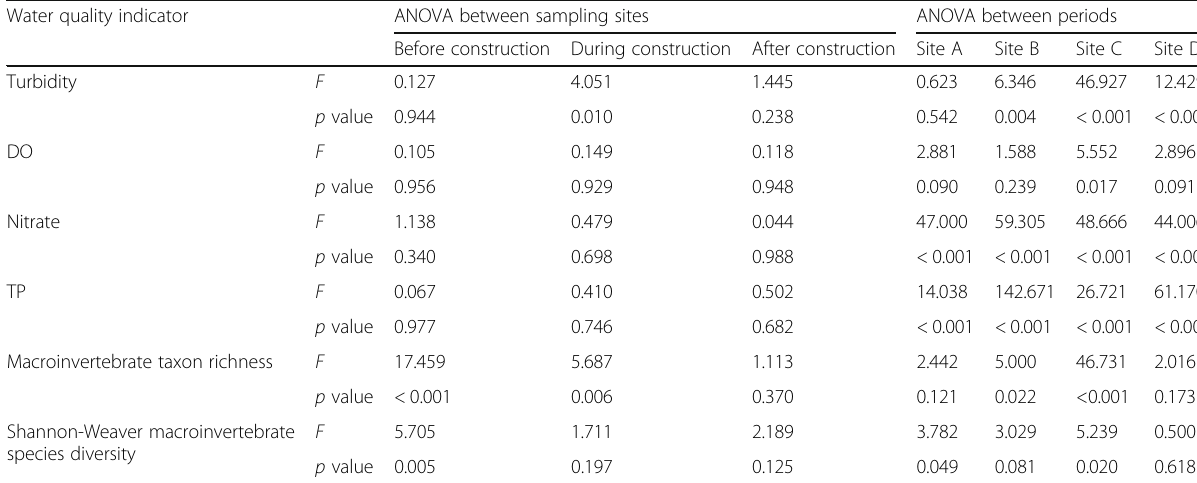
Table 1 Results of one-way ANOVA Water quality indicator